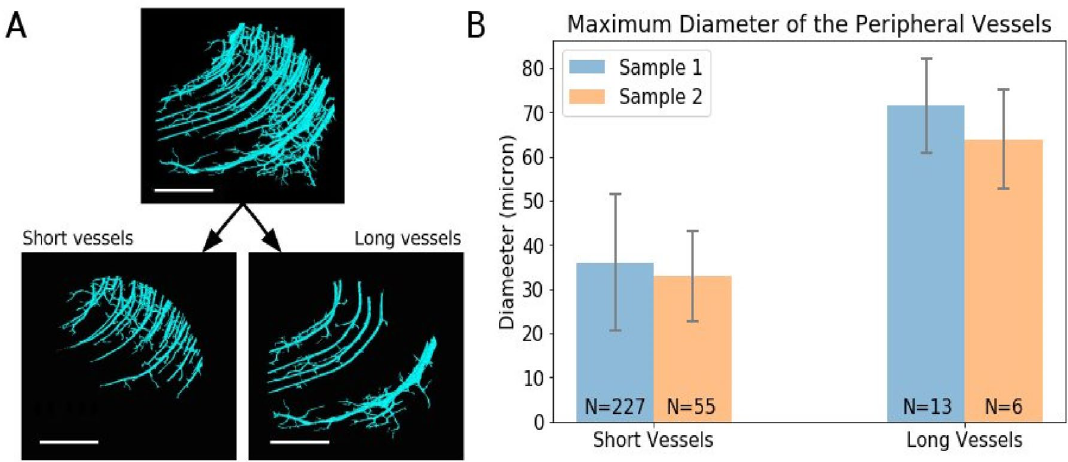
Figure 4. Identifying short and long peripheral collicular vessel. ( A ) Peripheral collicular vessels from sample 2. Top panel shows all the peripheral vessels. Bottom left panel shows the short peripheral vessels that end within the field of view. Bottom right panel shows the long peripheral vessels that reach the other end of the field of view. Scale bars = 1 mm. ( B ) The bar graph shows the average maximum diameter of the peripheral collicular vessels. The error bars indicate the standard deviation. N indicates the number of